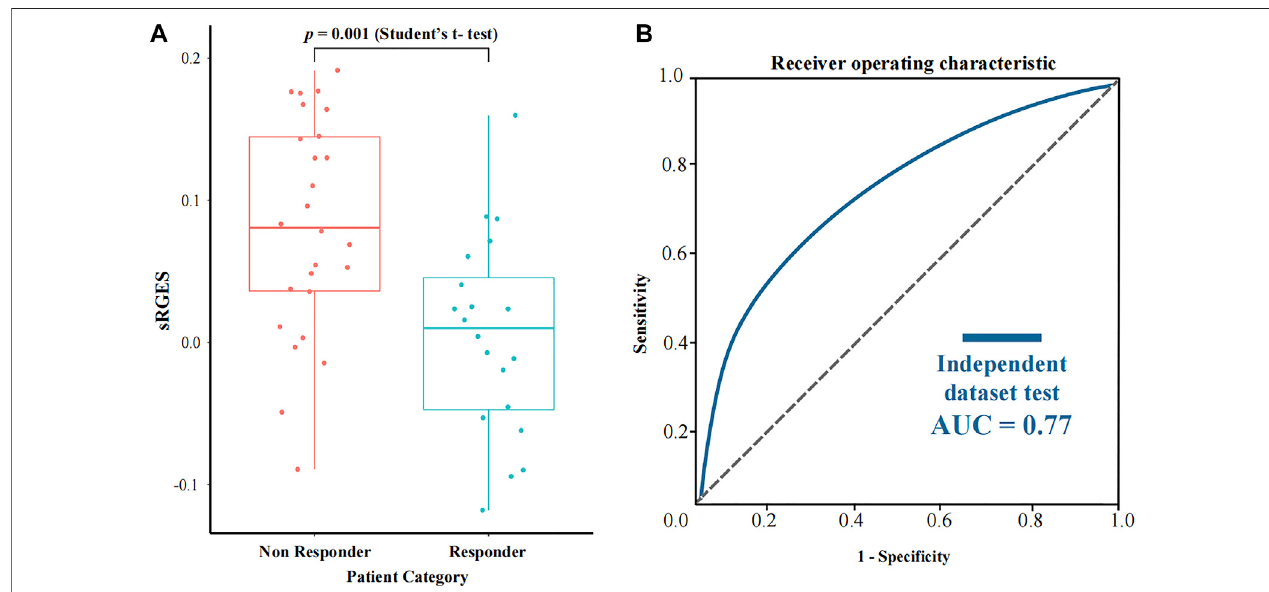
FIGURE 5 | Assessment results of CPDR on a pancreatic cancer dataset with clinical response to gemcitabine. (A) Differential analysis of sRGES scores between response and non-response groups by t -test. (B) ROC curve and AUC of the sRGES score of gemcitabine-discriminating responders and